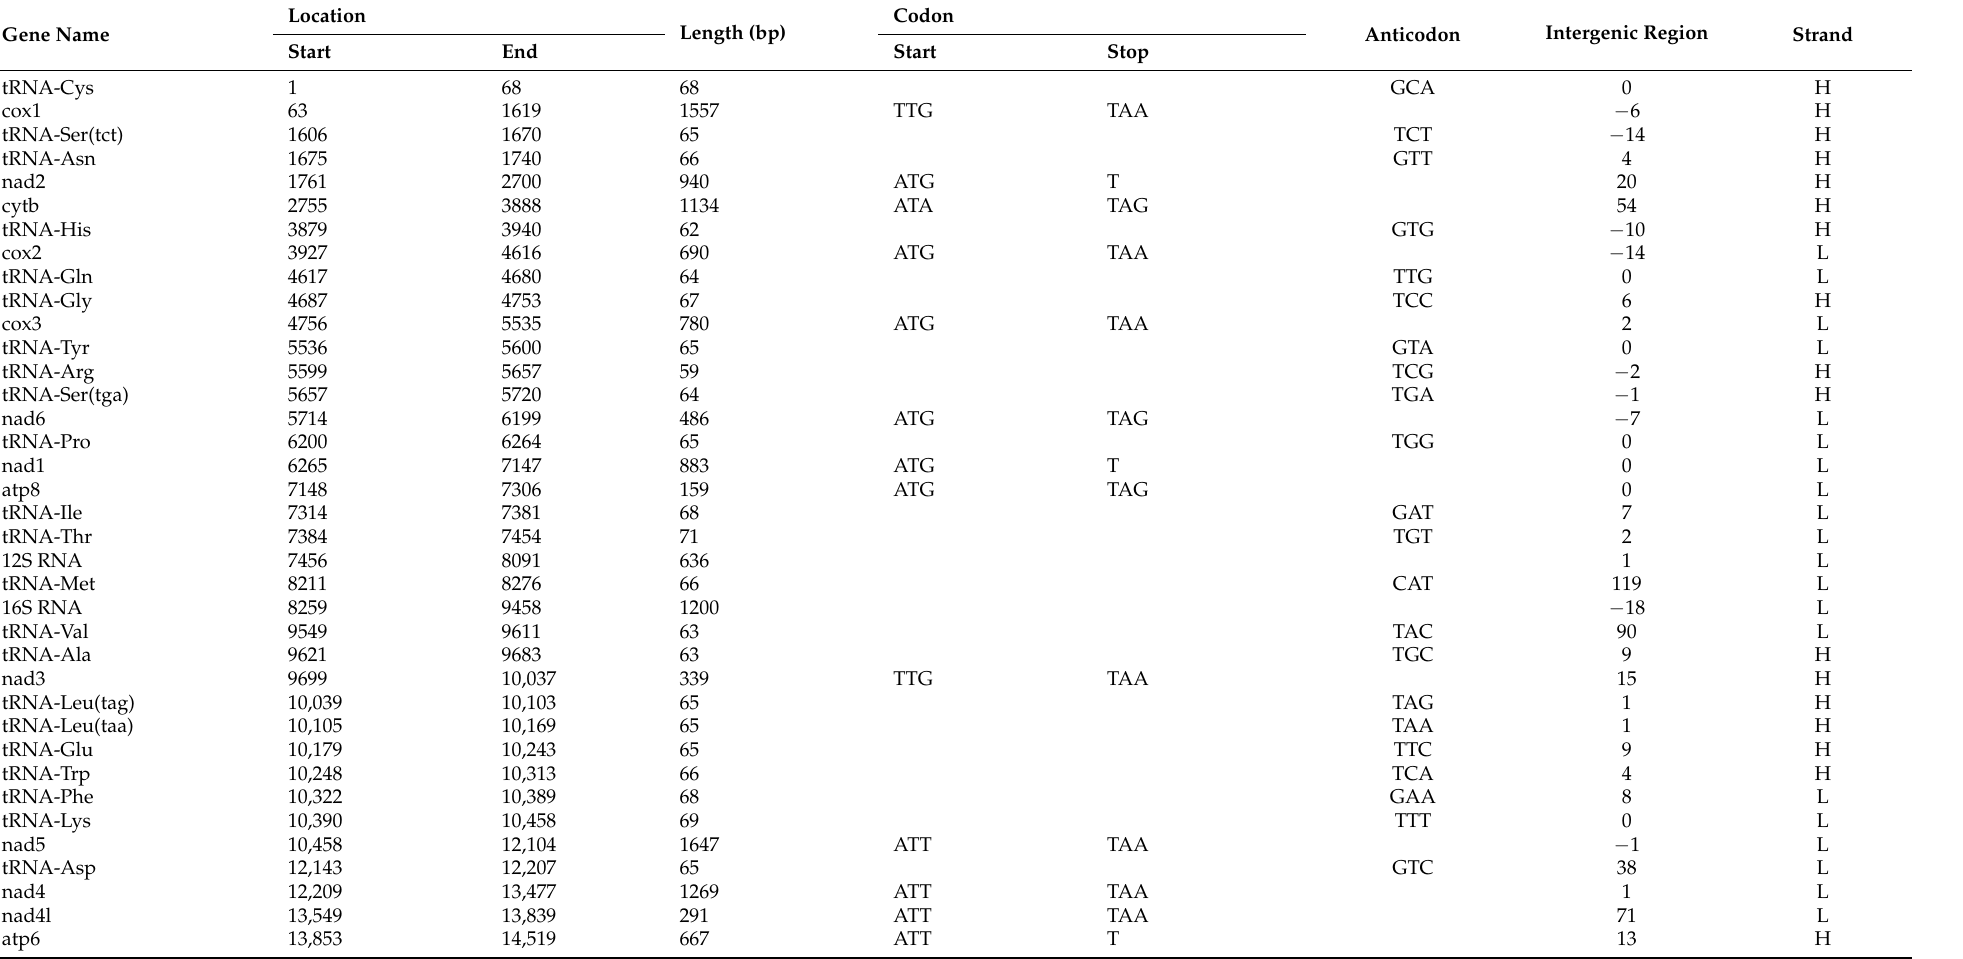
Table 2. Organization of the coding genes in P. vernedei mitochondrial